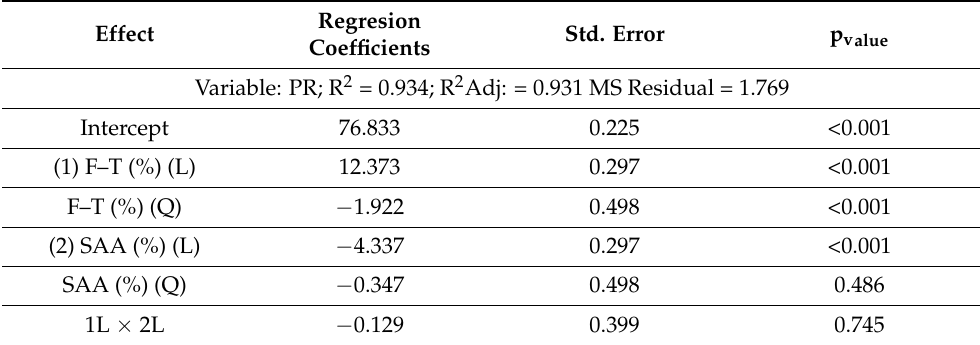
Table 7. Evaluation of the significance (ANOVA) of the factorial impact (F–T wax and SAA) on PR.